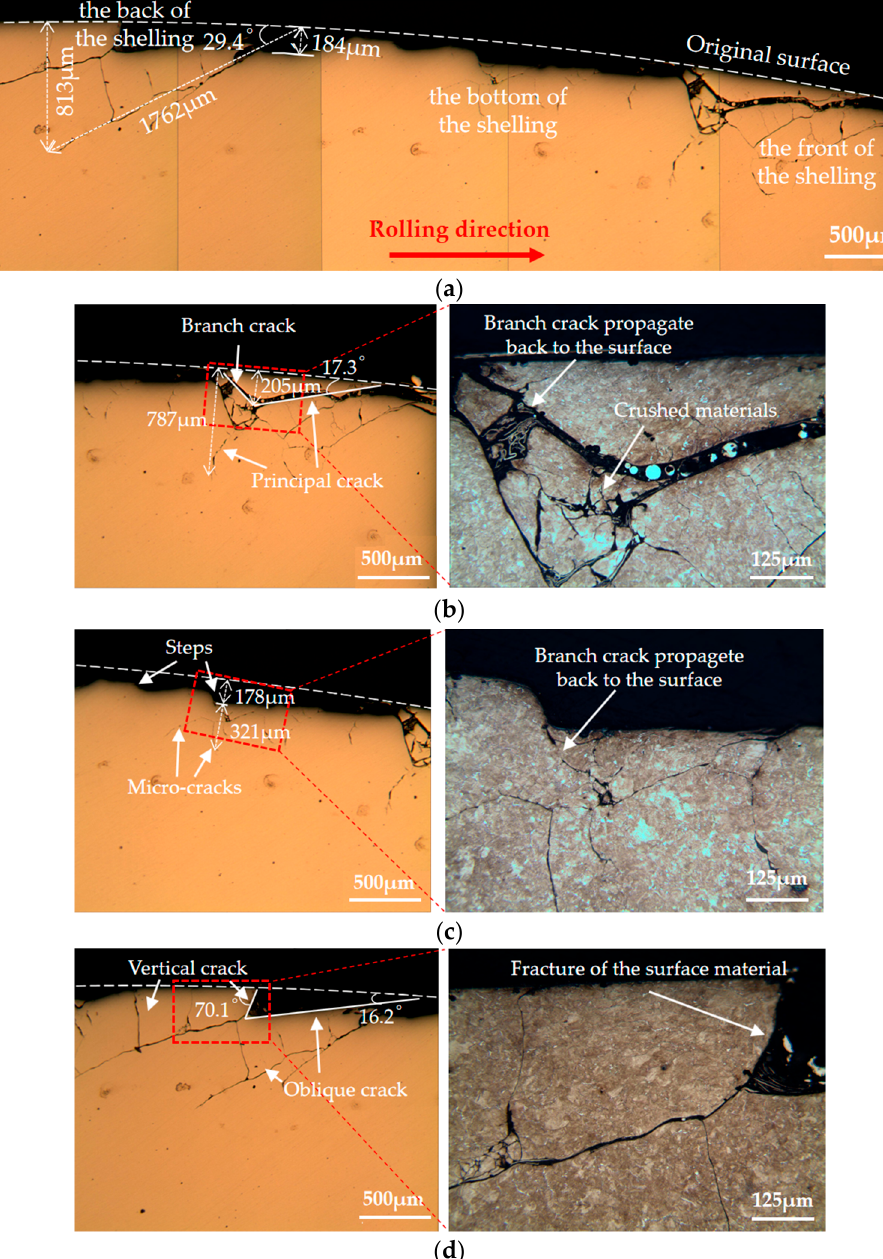
Figure 8. Subsurface damage around the shelling on wheel 2 (improved wheel): ( a ) the overall view; ( b ) the front, ( c ) the bottom and ( d ) the back of the shelling.